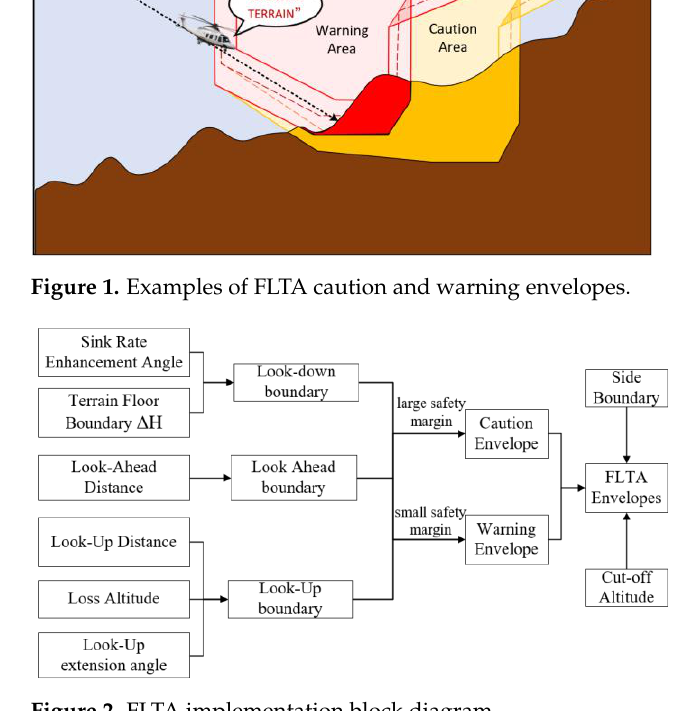
Figure 2. FLTA implementation block diagram. 98